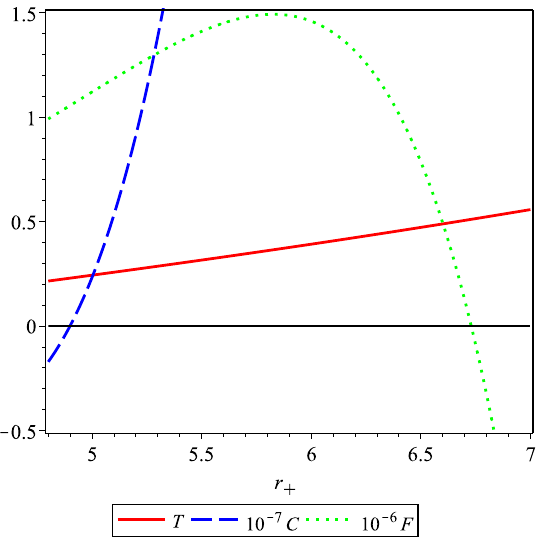
Figure 3 . Behavior of T , C and F versus r + for k = − 1 , n = 5 , x = 2 and α = 1 for “ − ” sign